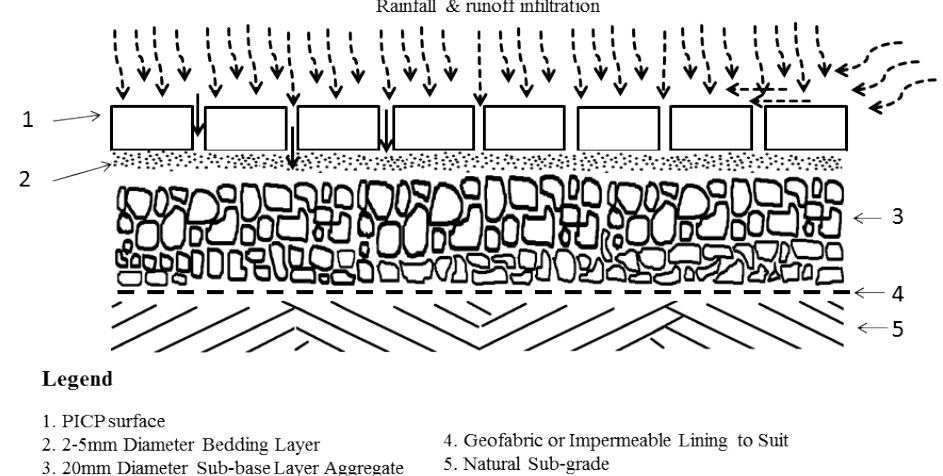
Figure 1. Typical Permeable Interlocking Concrete Pavement (PICP)